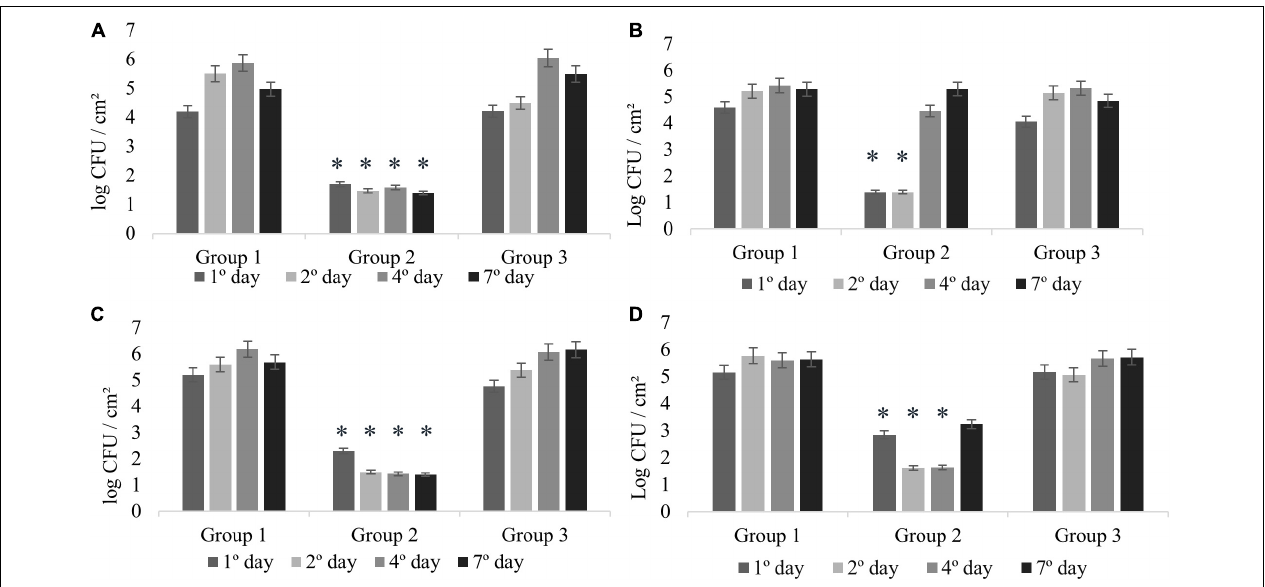
FIGURE 2 | Counts of L. monocytogenes at 25 ◦ C expressed in log CFU/cm 2 . Experiment 1 (A) in presence of B. cereus producer and non-producer of antagonistic substance; Experiment 2 (B) in presence of antimicrobial extract; Experiment 3 (C) in presence of B. cereus pre-adhered; and Experiment 4 (D) in presence of L. monocytogenes pre-adhered. ∗ p <